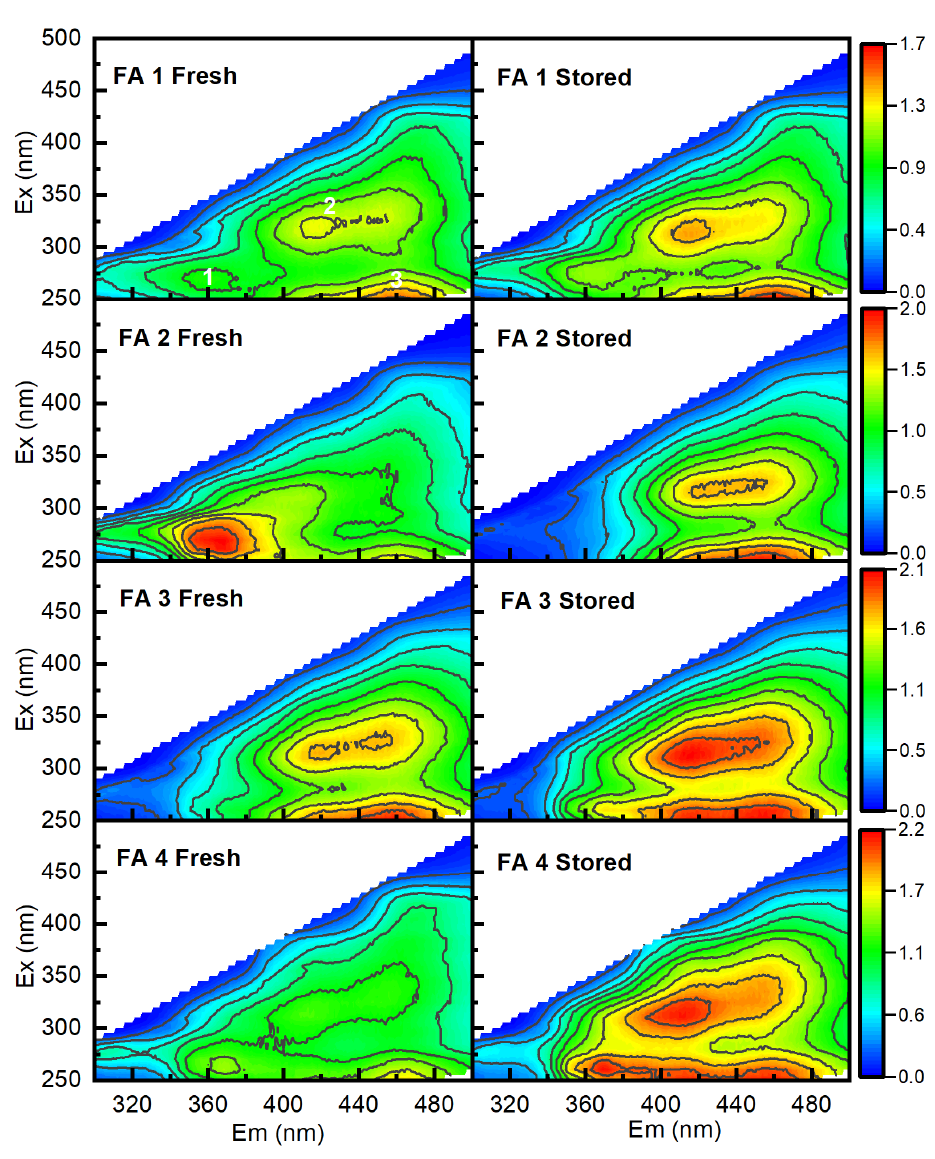
Figure 3. Excitation-emission matrix (EEM) fluorescence spectra of FA extracted from sewage sludge samples. Numbers indicate the considered